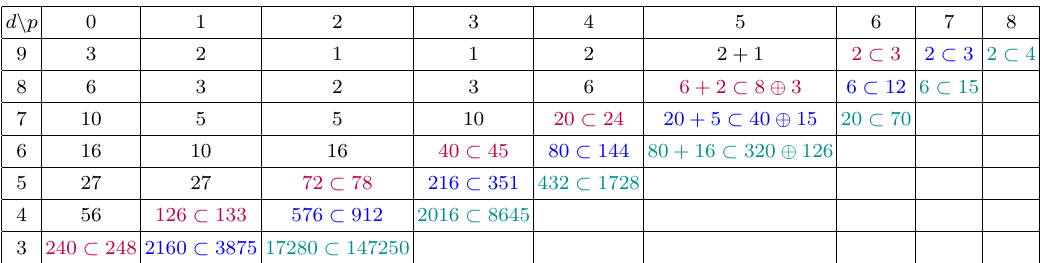
Table 3 . Dimensions of the p -brane multiplet and numbers of branes in the same Weyl orbit as the highest weight state. Only the 5-brane multiplet consists of two irreducible representations. This table was originally obtained in [30] from a discussion based on the E 11